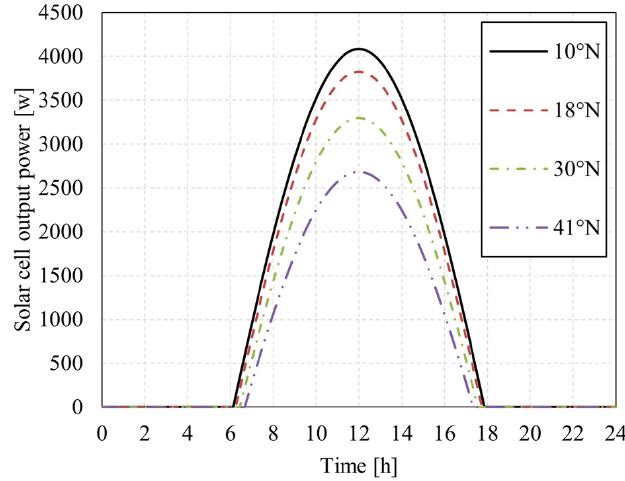
Figure 30. Comparison of PV cell output power at different latitudes (Feb. 21).